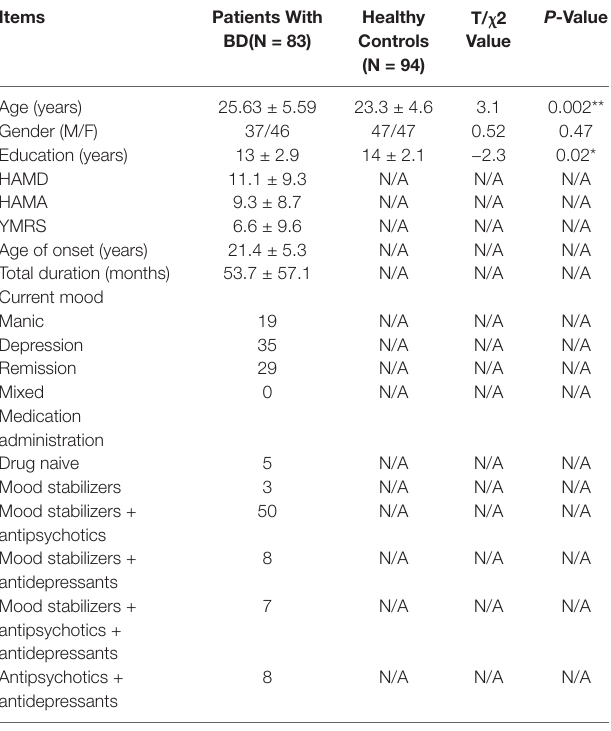
TABlE 1 | Demographic and clinical data. Items Patients With BD(n =